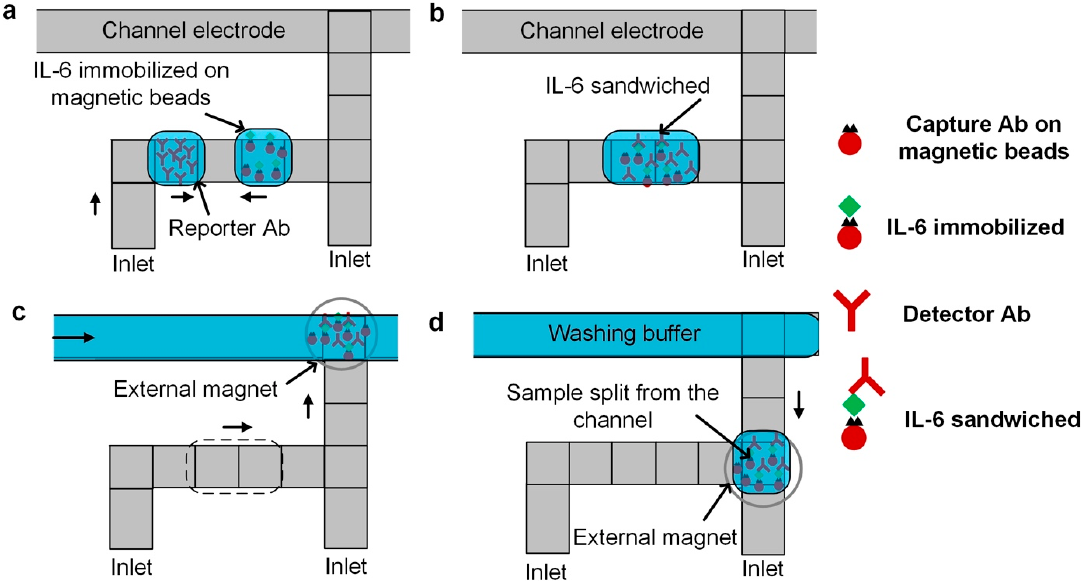
Figure 2. Sample washing in a heterogeneous immunoassay on a digital microfluidic platform. ( a ) Dispensing of reagents, ( b ) mixing and incubation of reagents, ( c ) introducing the droplet of immobilized sample into an electrowetting virtual channel for sample washing, and ( d ) splitting a droplet of washed sample from the electrowetting